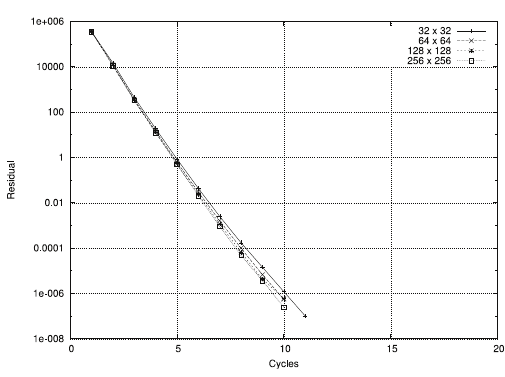
Figure 3. Multigrid convergence F(2,2)-cycle, pointwise distributive